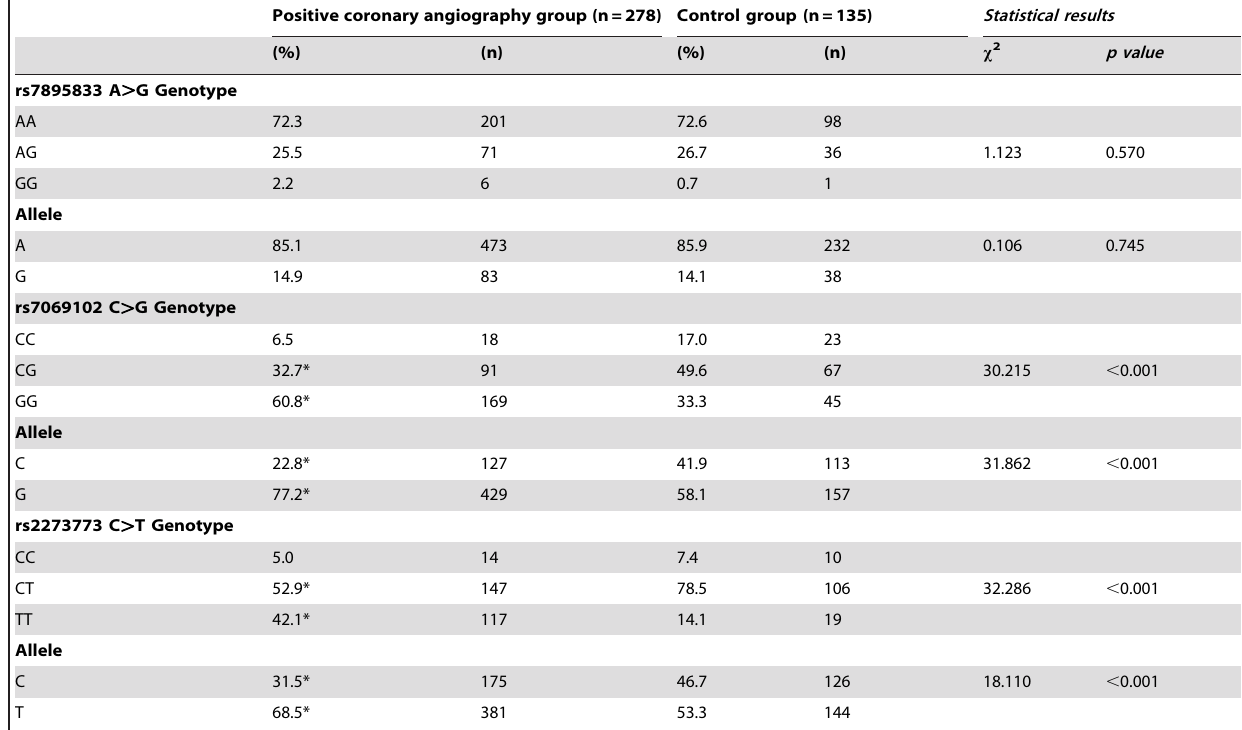
Table 5. Distribution of rs7895833 A . G, rs7069102 C . G and rs2273773 C . T genotypes and alleles in study groups.